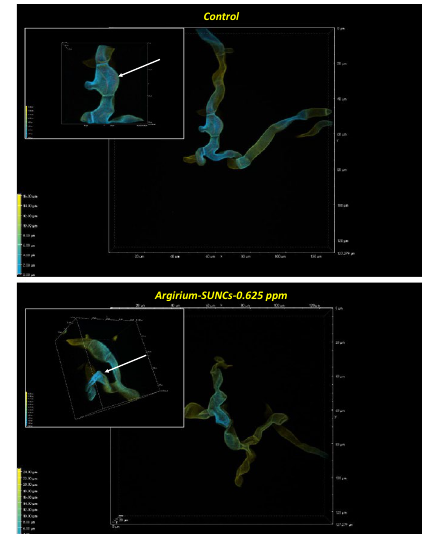
Figure 4. Release of intracellular proteins from A. niger GM31 before and after treatments with Argirium- SUNCs : ( A ) Protein concentration (μg/g dry biomass) in the supernatant medium after 18 h of incubation with the Argirium-SUNCs at 28 °C ; ( B ) morphological change as indicate by arrow (magnification picture) after 18 h of 0.625 mg Argirium-SUNCs exposure at 28 °C treatments.